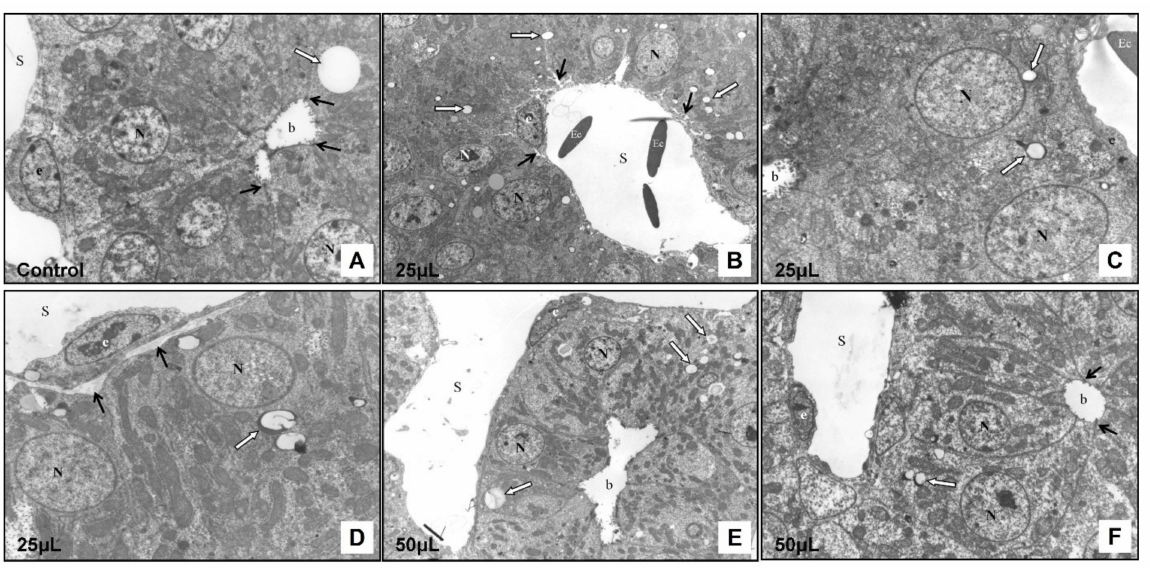
Figure 7. Transmission electron microscopy of the chicken developing liver. ( A ): Control group, magnification: 6500 × ; ( B ): Experimental group—25 µ L of DMSO administration, magnification: 4000 × ; ( C ): Experimental group—25 µ L of DMSO administration, magnification: 7500 × ; ( D ): Experimental group—25 µ L of DMSO administration, magnification: 6800 × ; ( E ): Experimental group—50 µ L of DMSO administration, magnification: 2800 × ; ( F ): Experimental group—50 µ L of DMSO administration, magnification: 5100 × ; N—nucleus of hepatocyte, S—sinusoid, e—endothelial cell, Ec–erythrocyte, b—bile canaliculus, white arrow—lipid droplet, black arrows—intercellular junctions ( A , F ), black arrows—space of Disse ( B , D ).